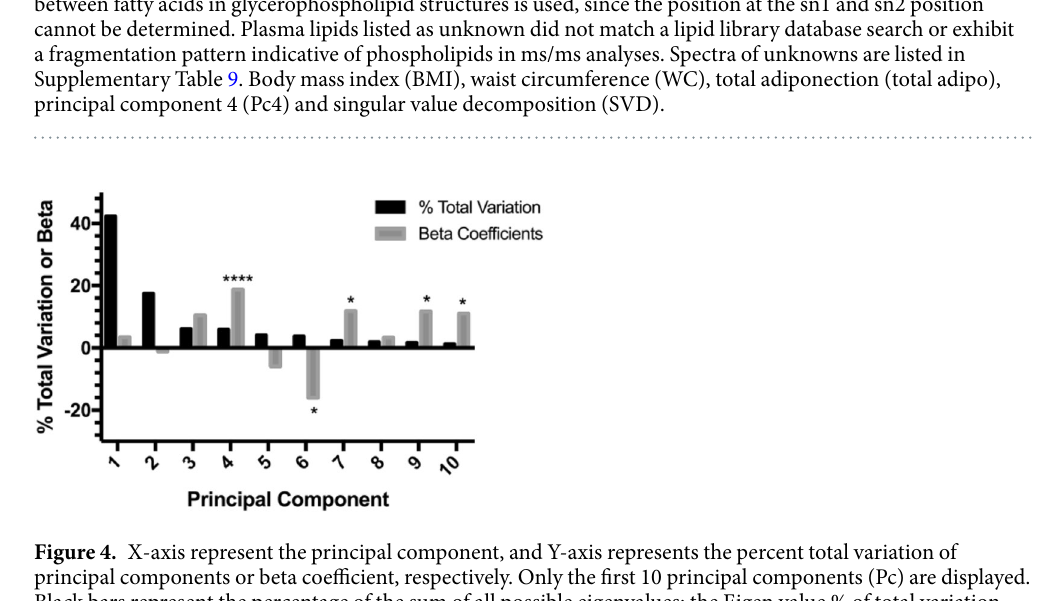
scores, and the lipids respective Bonferroni corrected p-values are presented in Supplementary Table 8.